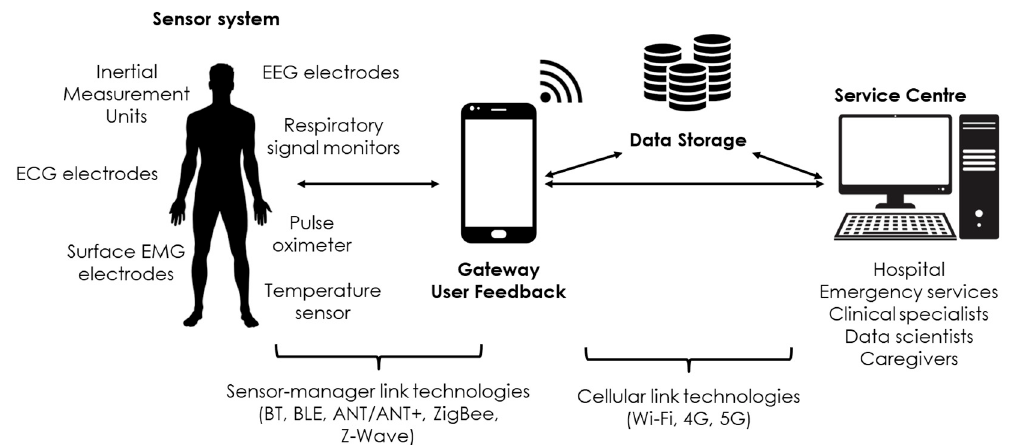
Figure 5. Telemonitoring system with a two-hop data transmission architecture. The figure was adapted from [2].